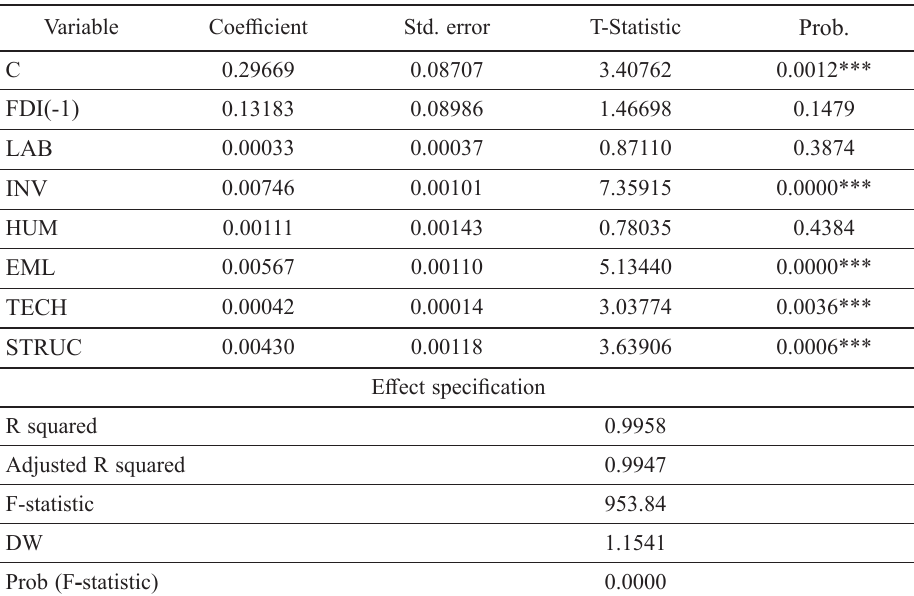
Table 5. Fiscal decentralization effect on economic growth in high level economic development